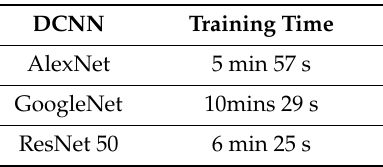
Table 8. The elapsed time of AlexNet, GoogleNet, and ResNet 50 DCNNs.